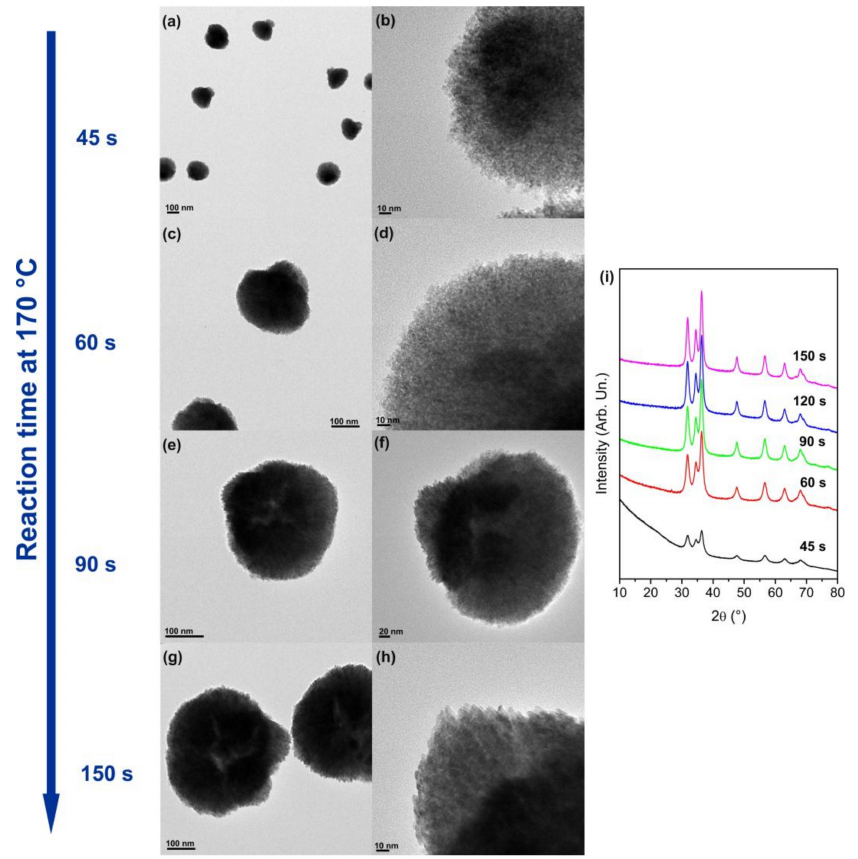
Figure 2. ( a – h ) TEM images and ( i ) XRD patterns of the products obtained at different reaction times during the synthesis of Co 0.15 Zn 0.85